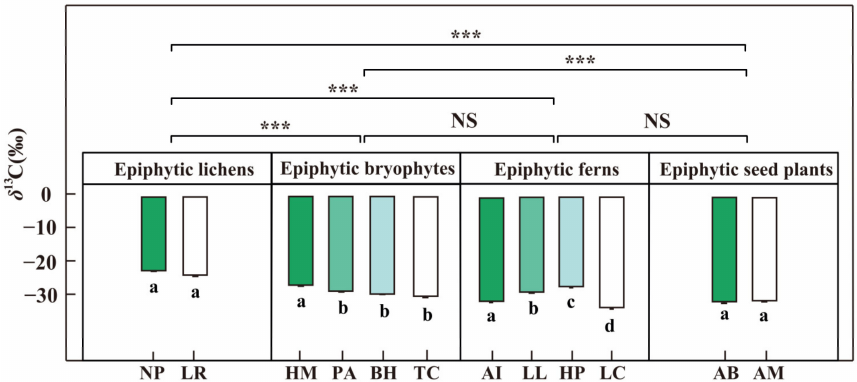
Figure 6. The δ 13 C (‰) of mature leaves of epiphytes from different groups in the dry season, January 2019. Wilcoxon rank-sum test is used to verify the differences of epiphyte samples (NS > 0.05, *** p < 0.001); Error bars represent mean ± SE and different letters with bars represent significant differences for each species ( p < 0.05). The abbreviations of species names are the same as in Figure